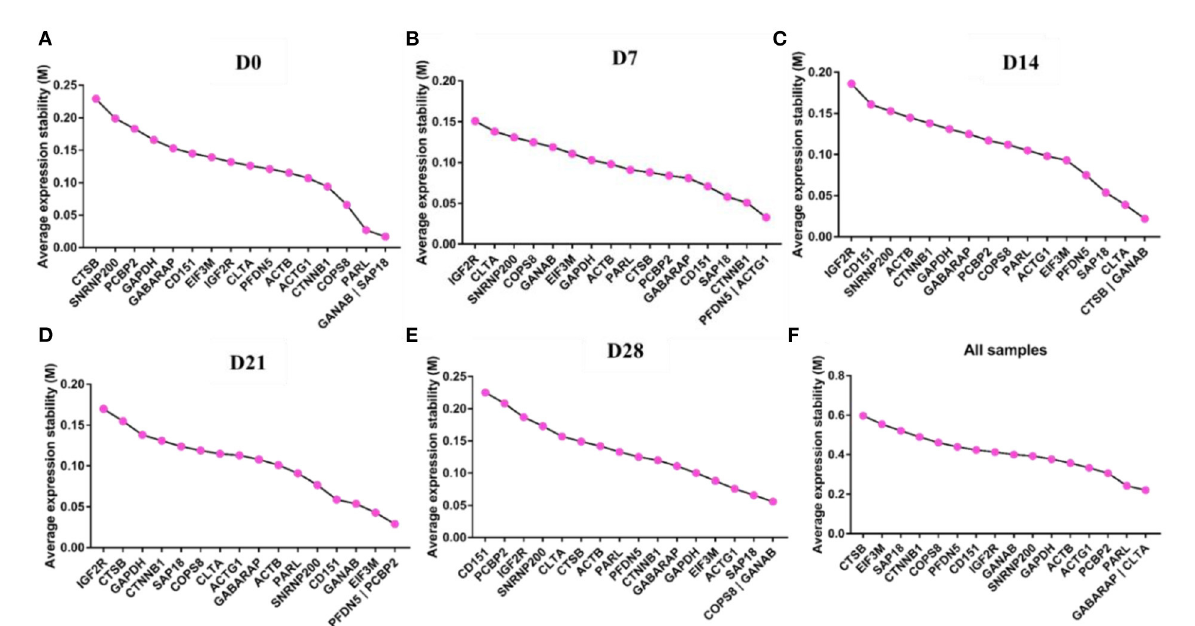
FIGURE4 GeNorm analysis the average expression stability of candidate reference genes. (A) D0, (B) D7, (C) D14, (D) D21, (E) D28, and (F) All samples including